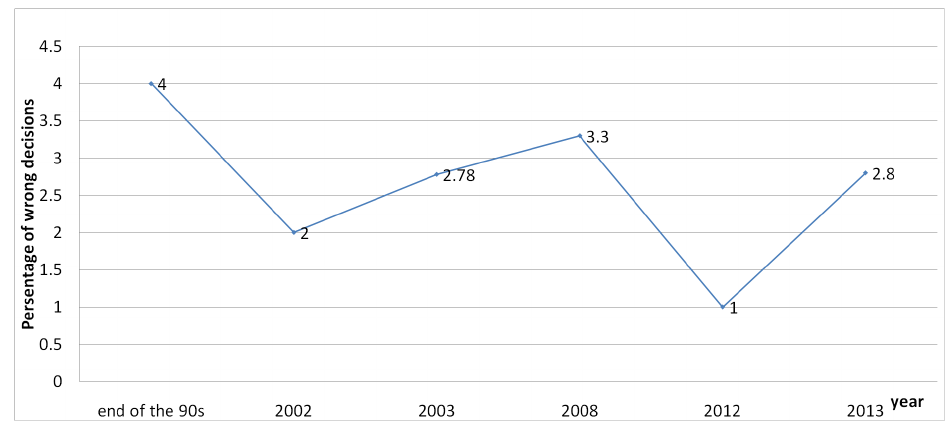
Figure 1. The best results in recognizing users via signatures explored in the past